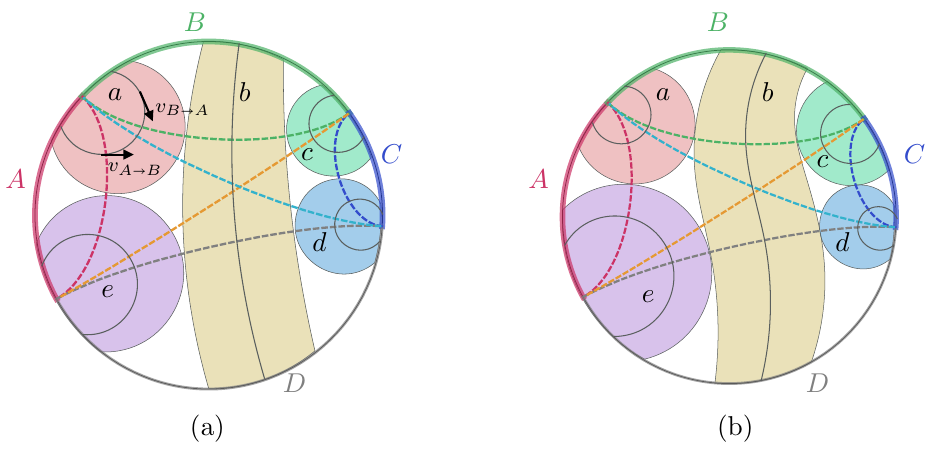
Figure 2 . Separate components ( thread bundles ) of the maximizer (cid:13)ows v passing through separate parts of the corresponding minimal surfaces as indicated, though only a single thread for each bundle is shown explicitly. Each thread bundle is con(cid:12)ned to its own spatial region, which we compactly label a (for A $ B bundle), b (for B $ D bundle), c (for B $ C bundle), d (for C $ D bundle), and e (for A $ D bundle). The two panels illustrate a residual 1-parameter freedom in the construction, further discussed in section 3.4.1. (a) In the a bundle, the arrows indicate that the same thread can be used in both directions, labeled v (b) The relative sizes of the thread bundles are not (cid:12)xed; one can vary them at the expense of e.g. bending the b